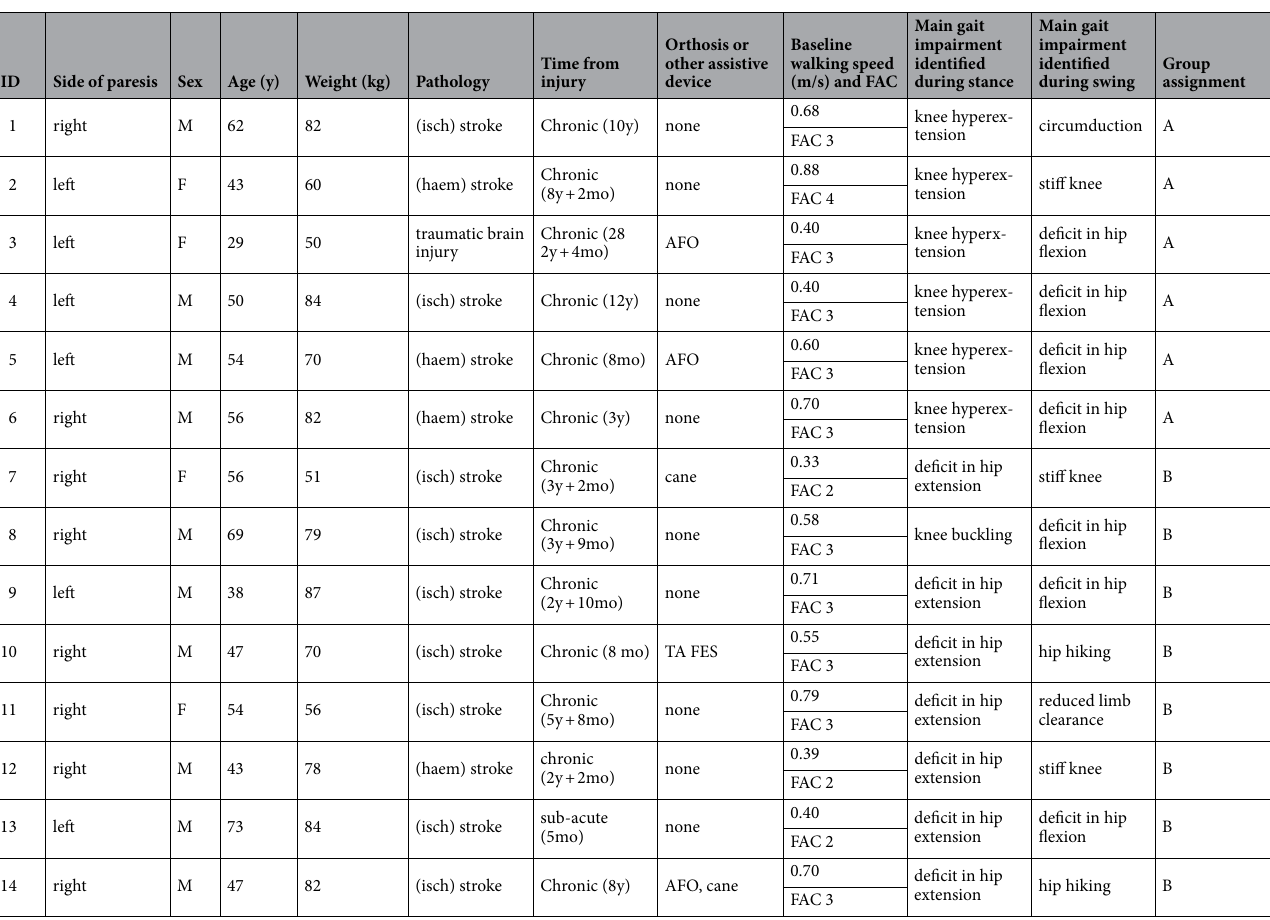
Table 1. Study participants’ characteristics. F female, M male, haem haemorrhagic, isch ischemic, y years, mo months, TA FES Functional Electrical Stimulation for Tibialis Anterior, AFO Ankle Foot Orthosis, m/s meters/ seconds, FAC Functional Ambulation